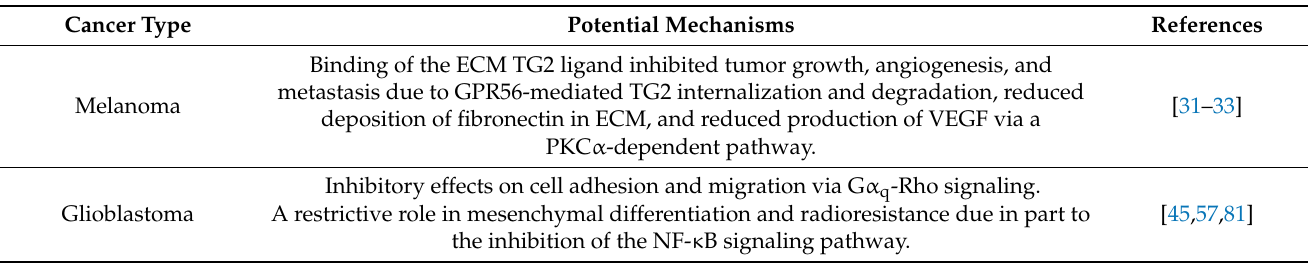
Table 2. The tumor-suppressive role of